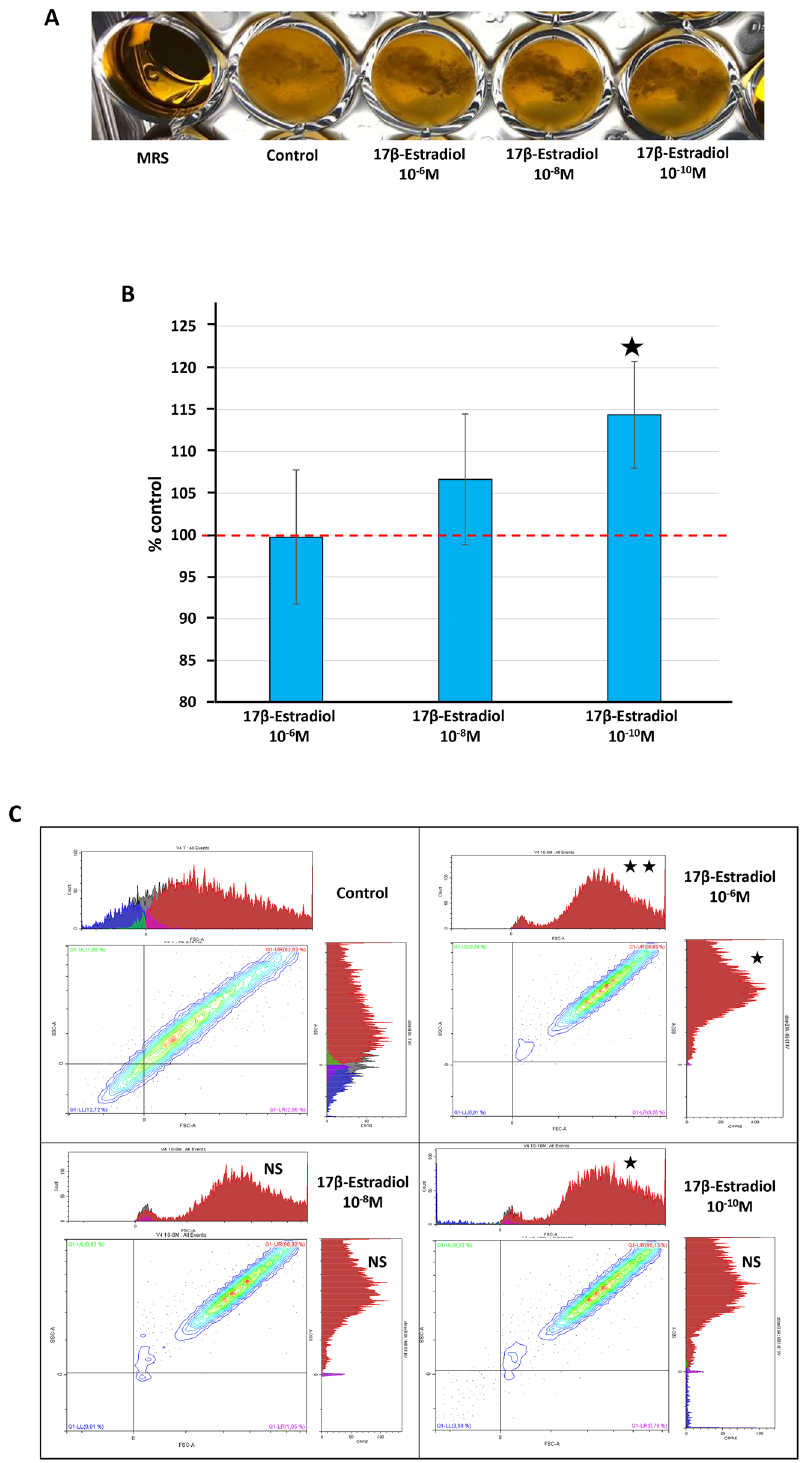
Figure 3. Effect of 17β-estradiol on the aggregation potential of Lactobacillus crispatus V4. ( A ) Typical aspect of L. crispatus V4 cultures, showing the formation of dense aggregates in the presence of 17β-estradiol (10 –6 , 10 –8 , and 10 –10 M). ( B ) Quantification of aggregate formation by L. crispatus V4 grown in the presence of 17β-estradiol (10 –6 , 10 –8 , and 10 –10 M), by the sedimentation technique. The red dotted line represents aggregate formation in control MRS medium. ( C ) Flow cytometry diagrams illustrating the effect of 17β-estradiol (10 –6 , 10 –8 , and 10 –10 M) on the mean size and aggregation [X axis = forward scattering fraction (FSC)] and surface heterogeneity (Y axis = side scatter (SSC)) of the bacteria. Values are presented as the means ± SEM of a minimum of three independent studies ( NS not significant, p < 0.05, p < ★ ★★